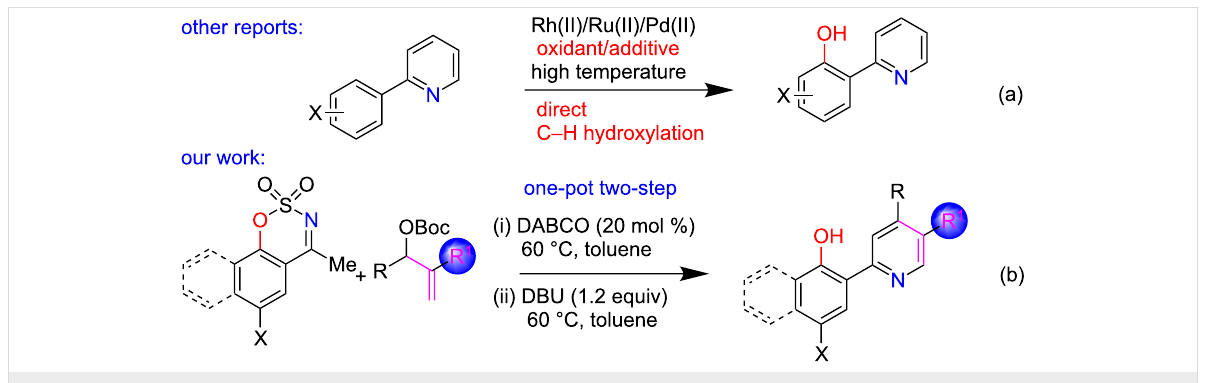
Figure 1: Drugs and agrochemicals having a nicotinic acid derivative.